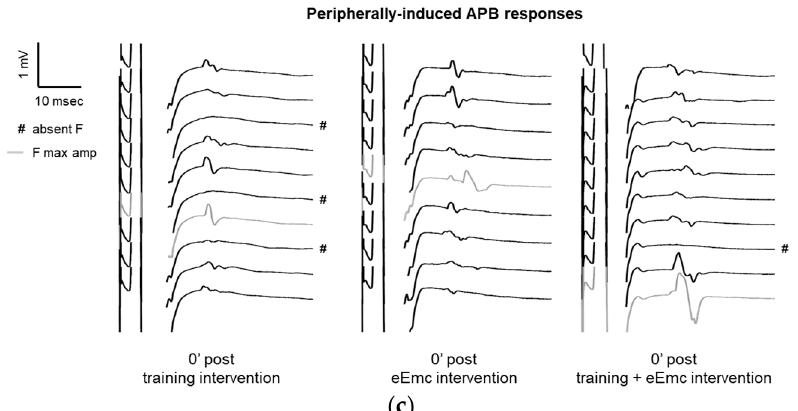
Figure 4. Variables of F waves in APB by median nerve stimulation. ( a ) F wave persistency. Significant difference between eEmc with training and training alone (regardless of the timepoint): p = 0.05. Data expressed as median ± interquartile range. ( b ) Averaged maximum amplitude of F wave for each condition and timepoint. Significant differences vs. baseline: + p < 0.05 (for training + eEmc), ++ p < 0.01 (for eEmc alone), and between interventions: (cid:70) p < 0.05. ( c ) Representative APB muscle registers (obtained from subject #7) corresponding to ten consecutive median nerve stimulations showing M and F wave at 0′ after in each intervention. Light grey registers highlight F waves with maximum amplitude. # Symbol indicates registers where no F wave presence was considered. APB, abductor pollicis brevis.